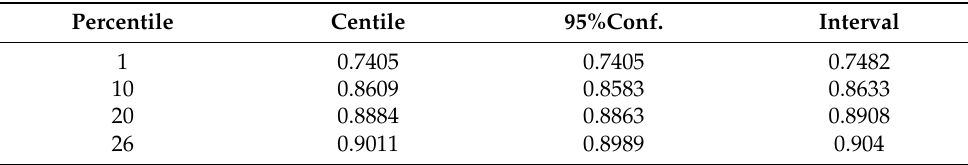
Table A1. The centile estimates of